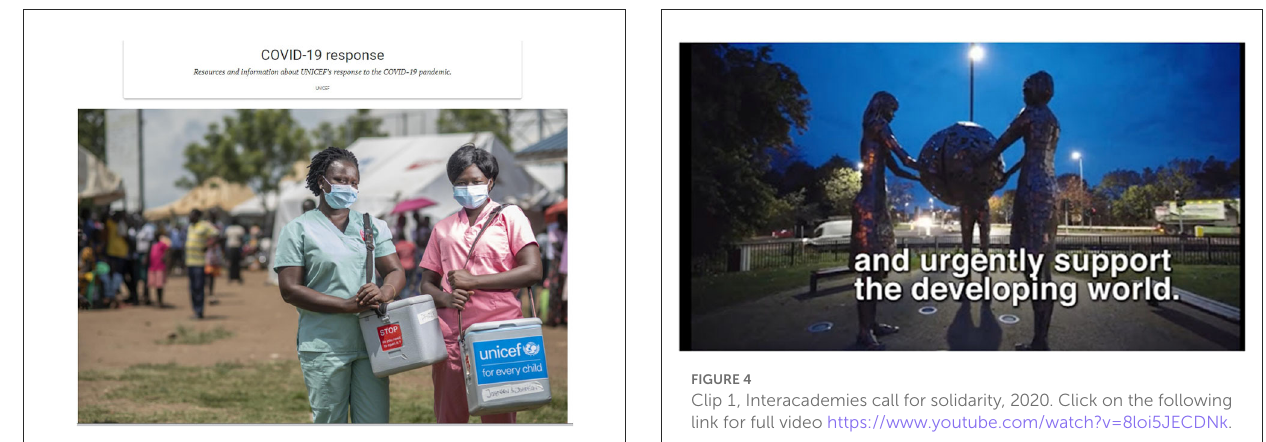
study, similar expressions of solidarity increase people’s sense